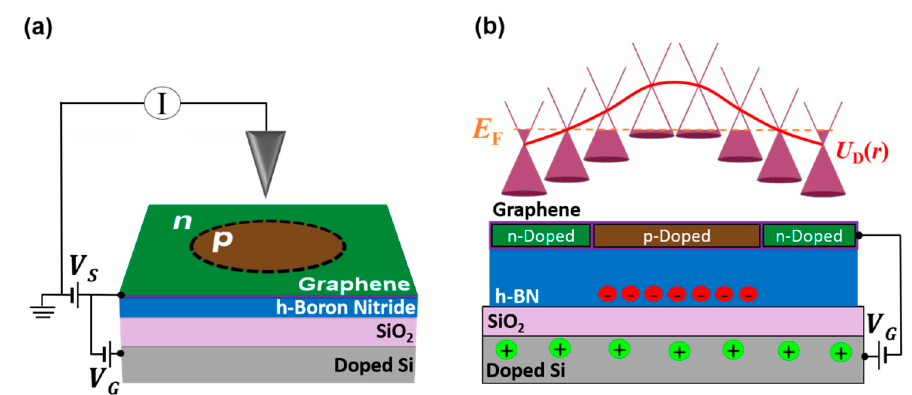
Figure 1. Schematic layout and potential of an exposed graphene Quantum Dot (QD). ( a ) Schematic showing the scanning tunneling microscope (STM) circuit and graphene / hexagonal boron nitride (hBN) heterostructure. The circular p -doped region outlines the QD created by applying a bias voltage ( V S ) pulse between the tip and the graphene / hBN heterostructure while holding the back-gate voltage ( V G ) constant. ( b ) Top: U D ( r ) (red curve) is the potential of the QD which is outlined by tracing along the Dirac point in each cone. Bottom: Side-view schematic of the QD in a graphene / hBN heterostructure for V G > 0. The application of a high electric field by the STM tip induces a localized net charge accumulation after exciting defects in hBN. Applying V G with opposite polarity to charges in hBN induces the spatial variation in doping on graphene which forms the QD